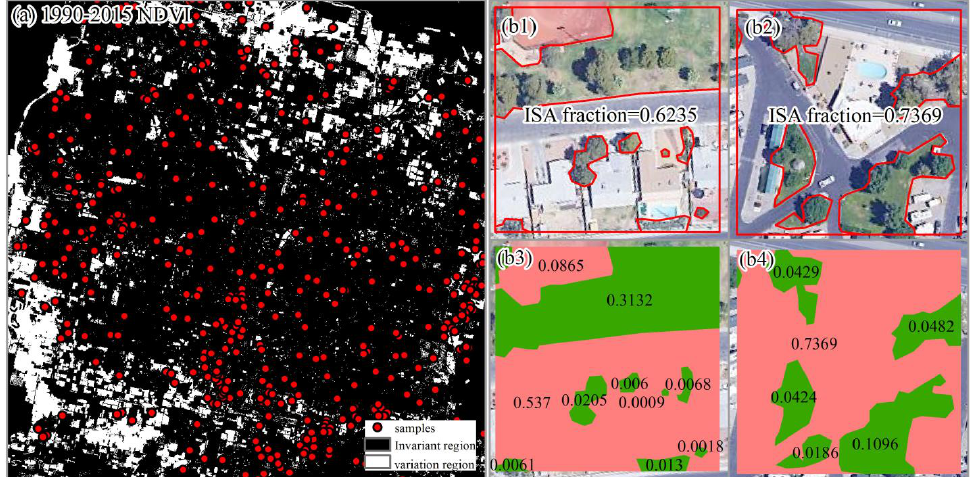
Figure 3. ( a ) shows the selection principle of the spatial distribution of sample points; ( b1 ) and ( b2 ) show the sampling areas in a Google Earth image; whereas ( b3 ) and ( b4 ) show the digitized proportions of the impervious (pink) and vegetation (green) areas.